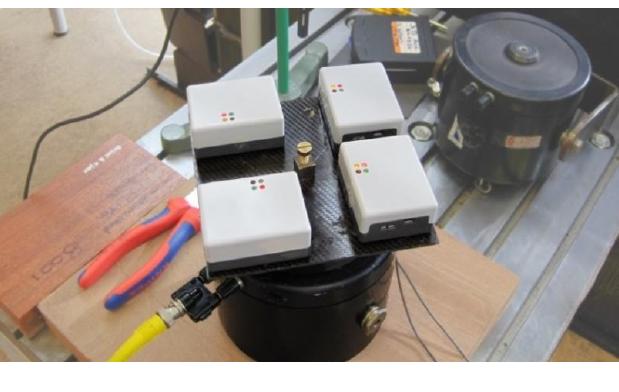
Figure 2. Setup of the sensors on the mechanical oscillator. Four ProMove2 sensors were